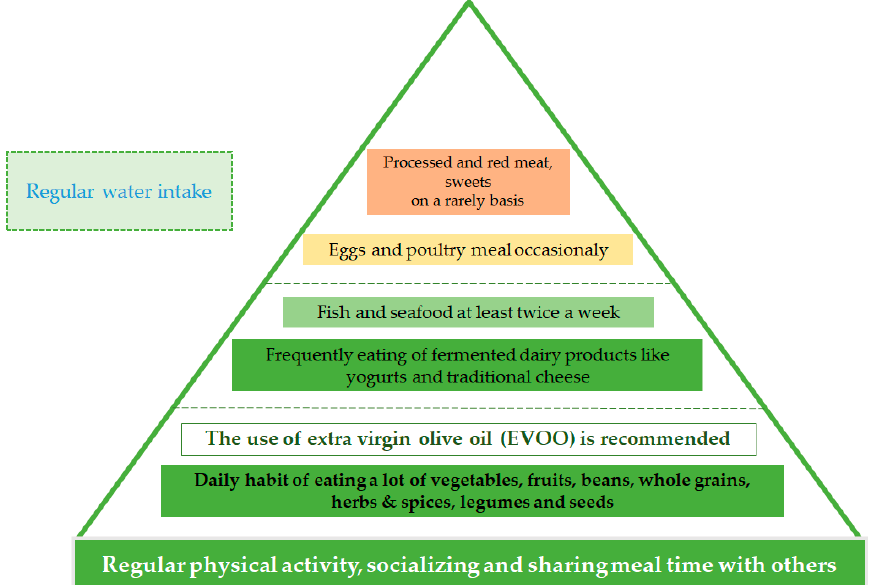
Figure 3. The foundation of the Mediterranean diet based on the original recommendation created by Oldways in partnership with the Harvard School of Public Health and the World Health Organization.